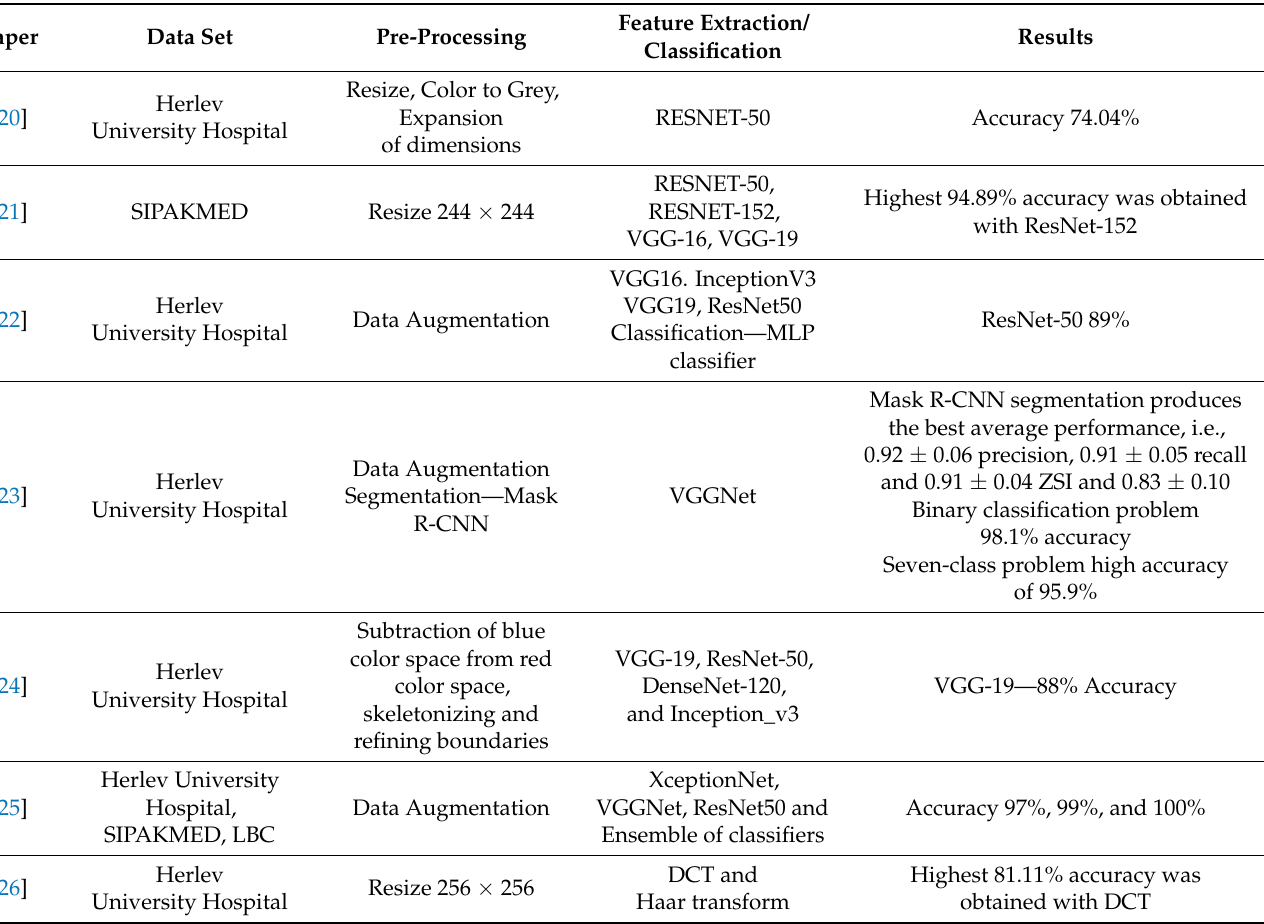
Table 1. Summarization of Prevailing Research